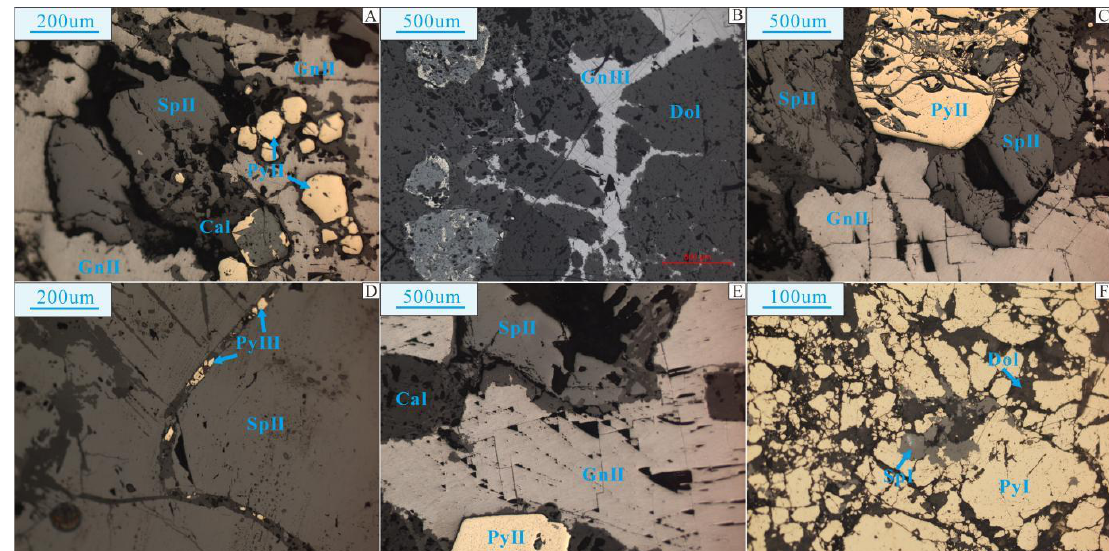
Figure 5. Mineral assemblages and sequence of Lekai Pb-Zn deposit. ( A ) Sphalerite, galena, and pyrite are hypidiomorphic-idiomorphic grain; Pyrite is surrounded by calcite, sphalerite, and galena form codissolved texture; ( B ) Veined galena metasomatized dolomite; ( C ) Sphalerite, galena, and pyrite are granularly cemented by calcite; ( D ) The later granular pyrite developed in veined calcite and metasomatized earlier formed sphalerite; ( E ) Pyrite, sphalerite, and galena show a codissolved texture; ( F ) A small amount of sphalerite is filled within the fracture zones of crushed pyrite. Sp = sphalerite; Py = pyrite; Gn = galena; Cal = calcite; Dol = dolomite.